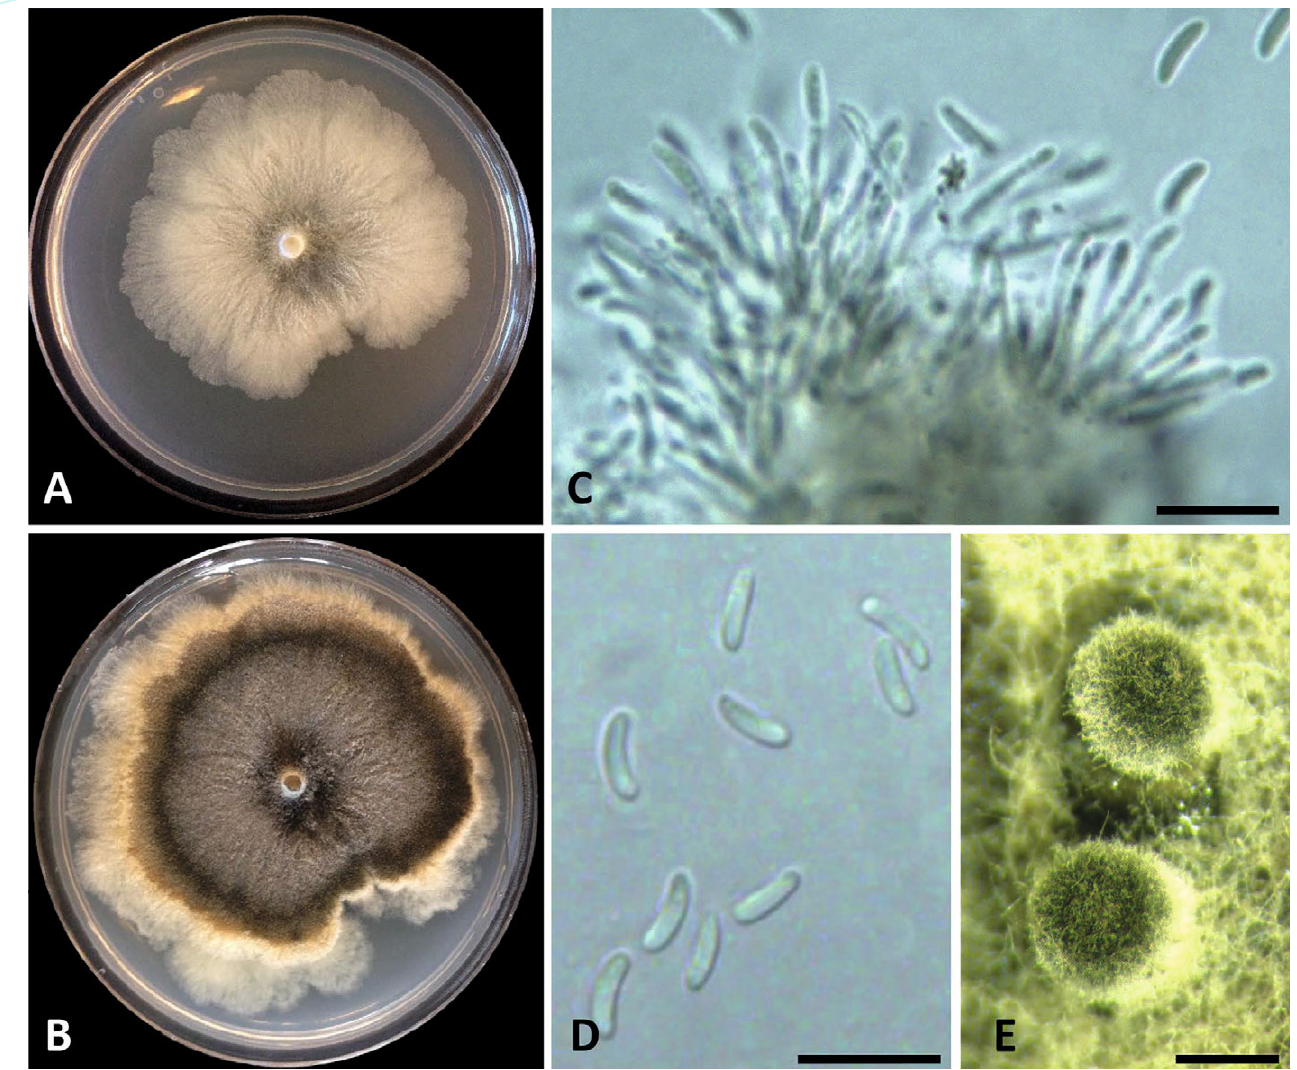
Fig. 5. Cytospora amygdali (ex-holotype culture CBS 144233). A. Seven-day-old PDA culture. B. Fourteen-day-old PDA culture. C. Conidiophores (cid:9)(cid:17)(cid:21)(cid:2)(cid:20)(cid:23)(cid:9)(cid:6)(cid:13)(cid:17)(cid:8)(cid:4)(cid:5)(cid:7)(cid:2)(cid:19)(cid:4)(cid:17)(cid:11)(cid:21)(cid:11)(cid:4)(cid:25)(cid:13)(cid:17)(cid:4)(cid:5)(cid:7)(cid:2)(cid:19)(cid:13)(cid:23)(cid:23)(cid:7)(cid:28)(cid:2) D. Conidia. E. Pycnidia. Bars C–D = 10 μm; E = 500